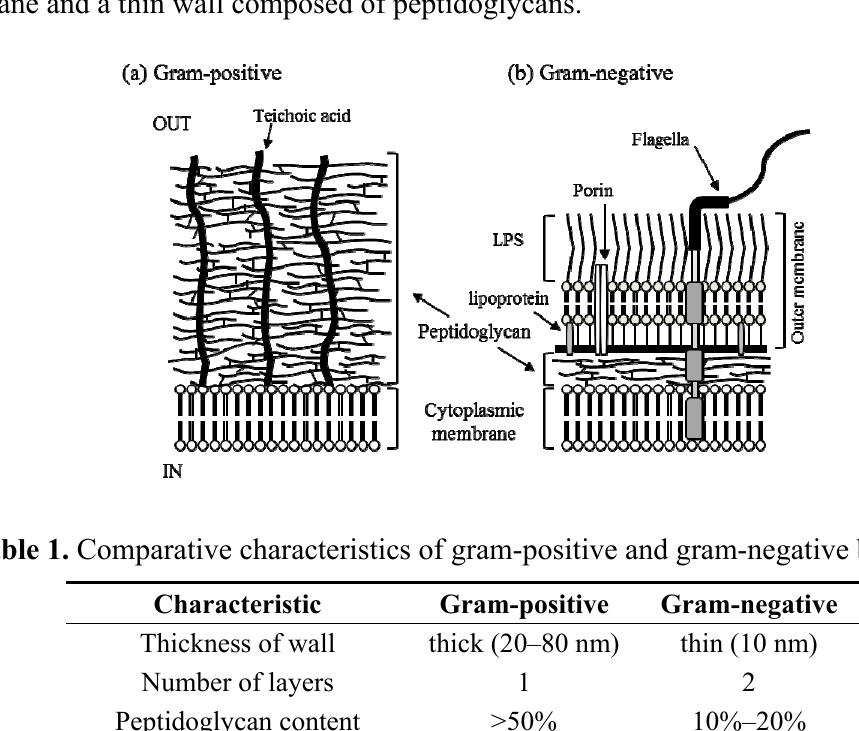
Figure 2. Structure of gram-positive and gram-negative bacteria: (a ) Gram-positive bacteria have a thick wall composed of peptidoglycans; and ( b ) gram-negative bacteria have an outer membrane and a thin wall composed of peptidoglycans.